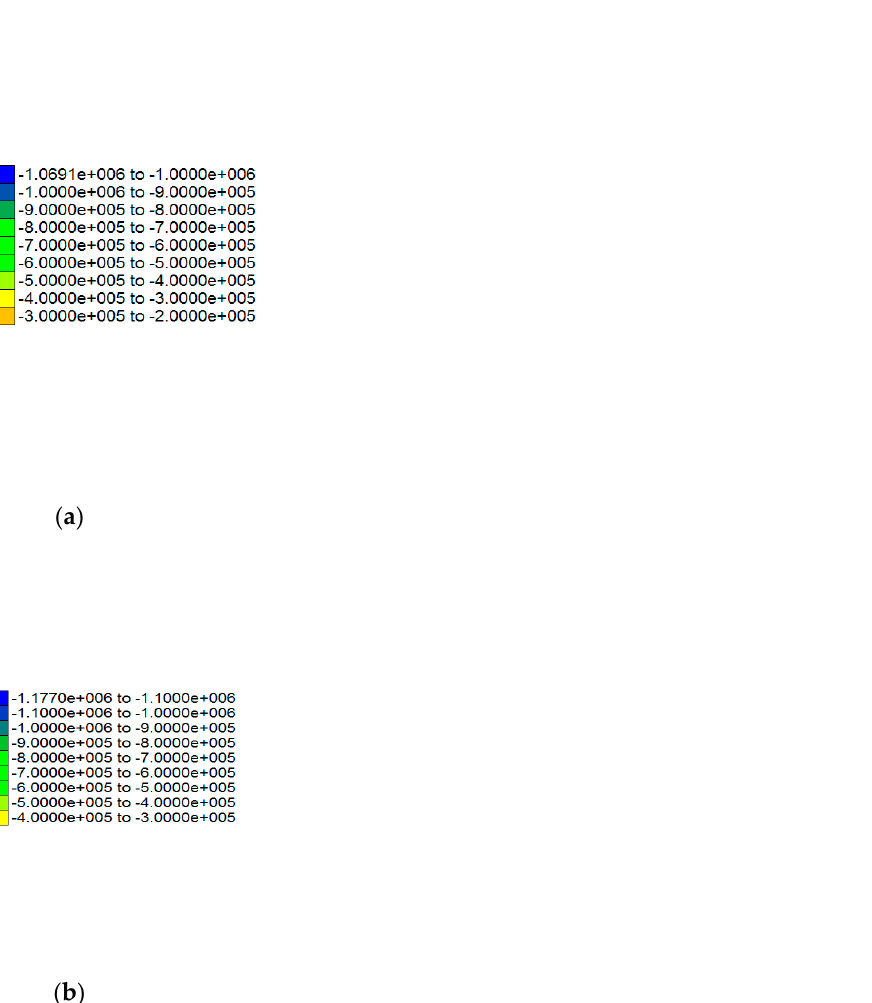
( b ) Figure 21. Comparison of minimum principal stress distribution of cut-off wall at monitoring sur- face. ( a ) 1. ( b ) 2.